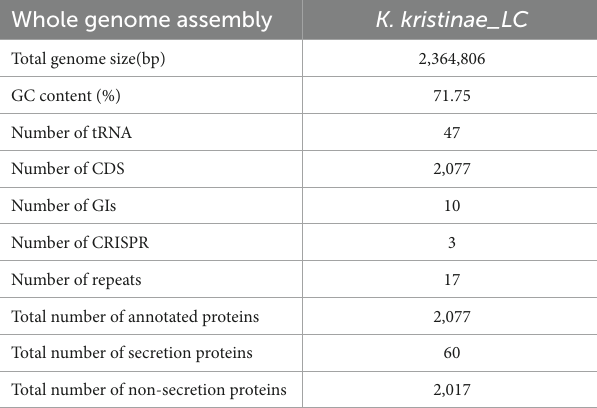
TABLE 2 Whole genome assembly features of the K. kristinae_LC